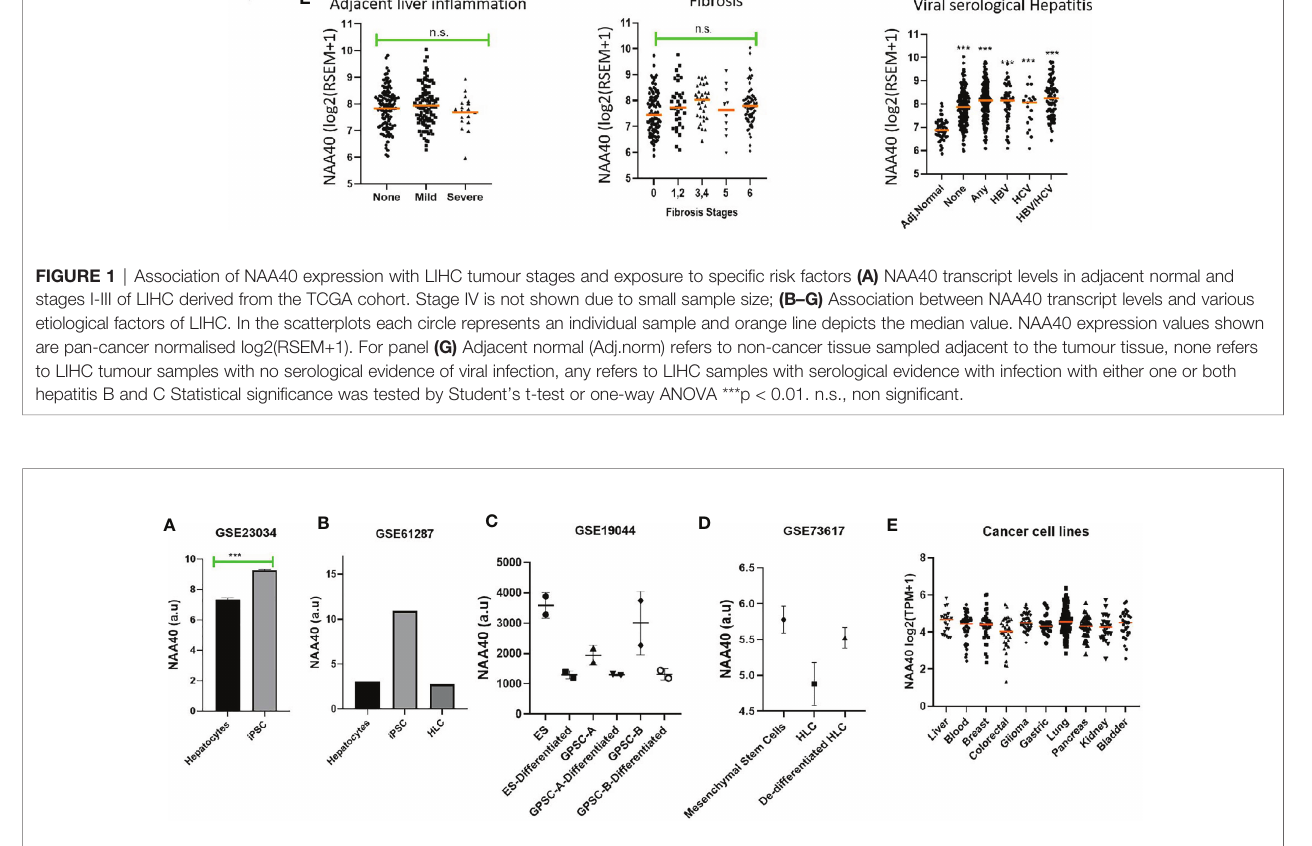
FIGURE 2 | NAA40 transcript levels inversely correlated with hepatocyte differentiation (A) NAA40 levels in primary hepatocytes before and after de-defferentiation into iPSC; (B) NAA40 transcript levels in another study similar to (A) but including expression data from iPSCs that are differentiated again into hepatic-like cells (HLC); (C) Expression of NAA40 in Embryonic Stem Cells (ES) and Germ line cell-derived pluripotent stem cells (GPSC) in untreated state and after 28 day treatment to induce differentiation into hepatic-like cells; (D) NAA40 expression in resting mesenchymal stromal cells, mesenchymal stem cells induced to differentiate into HLC and after these are dedifferentiated again; (E) NAA40 expression across cancer cell lines originating from various human organs. Each circle represents a different cell line. Orange line indicated the median expression for cells of a given tissue of origin. Arbitrary Units (A.U) refers to normalised microarray values without any further processing. ***p <